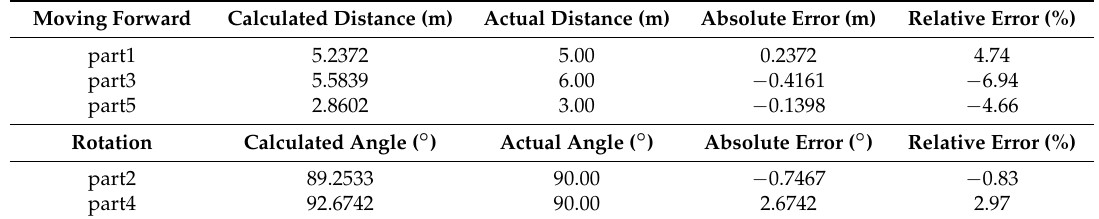
Table 4. Calculated Moving Distance and Rotation Angle of “Z” shaped test.